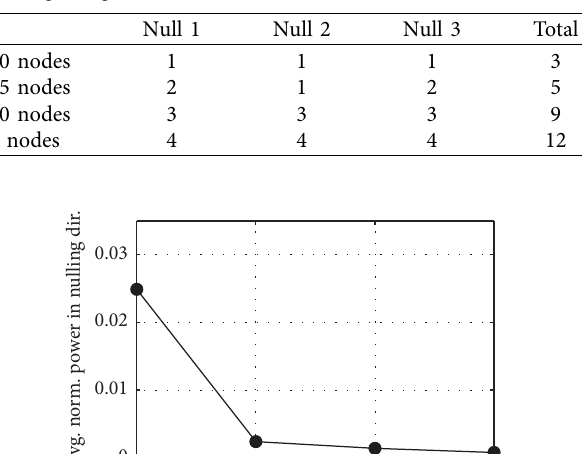
Table 9: Null depth performance ranking corresponding to null steering using 20, 15, 10, and 5 nodes.